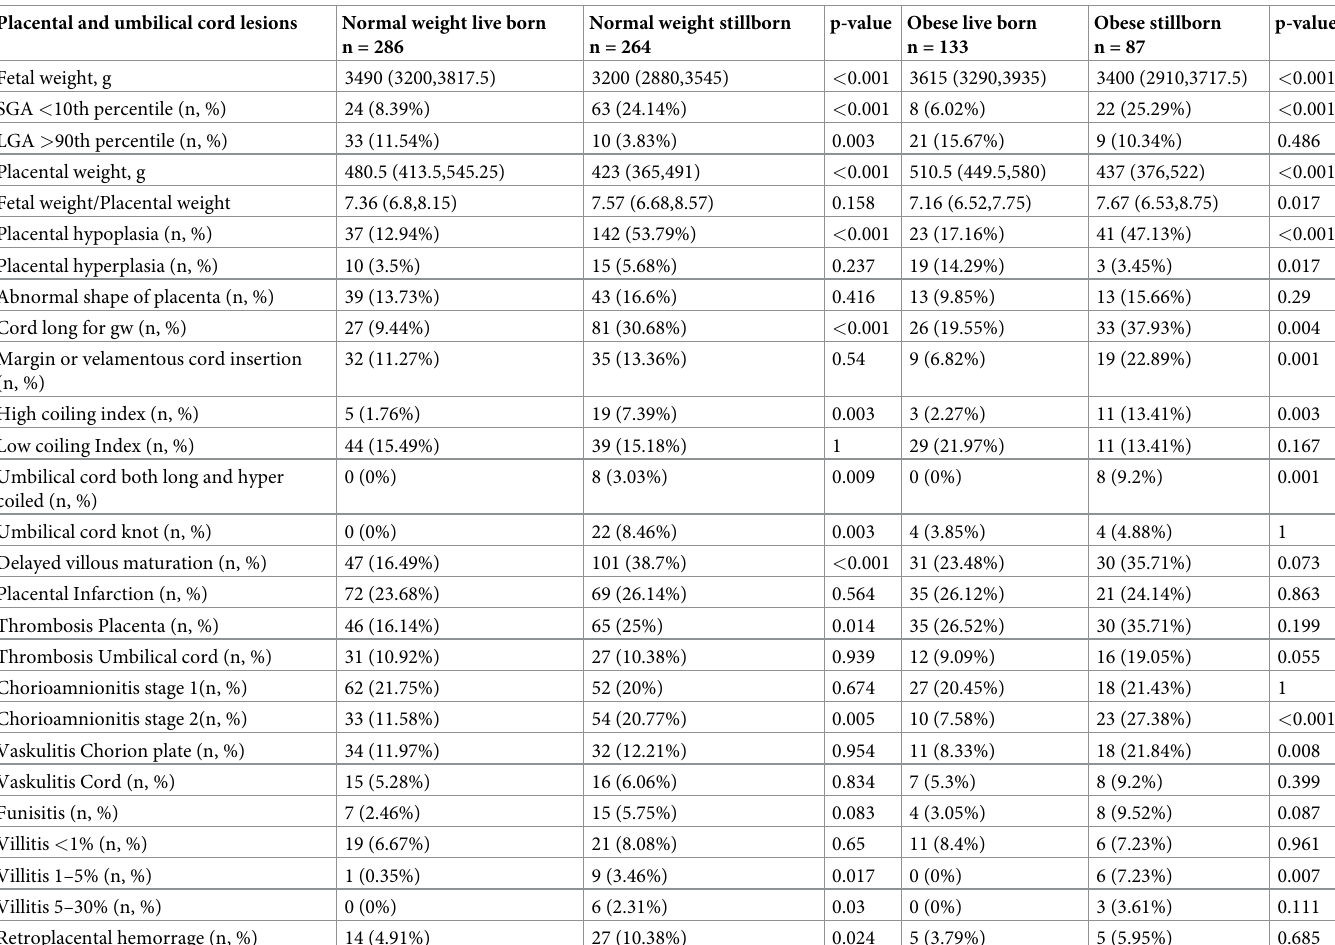
Placental characteristics, placental lesions and umbilical cord abnormalities for normal weight women (BMI 18.5–24.9 kg/m 2 ) and obese women (BMI � 30 kg/m 2 ) with term live born and stillborn fetuses, respectively. For continuous variables medians with interquartile range are expressed and for categorical variables numbers and proportions are